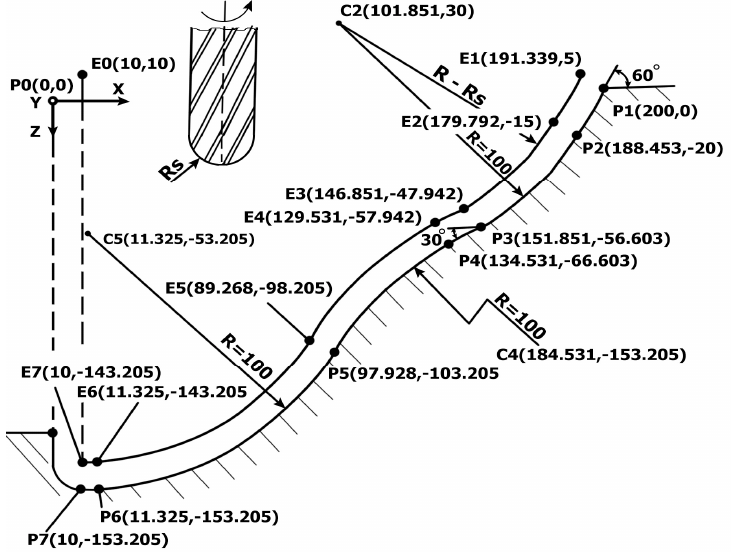
Figure 9. Characteristic points of the part ( Pi ), respectively those of the equidistant curve, ( Ei ).